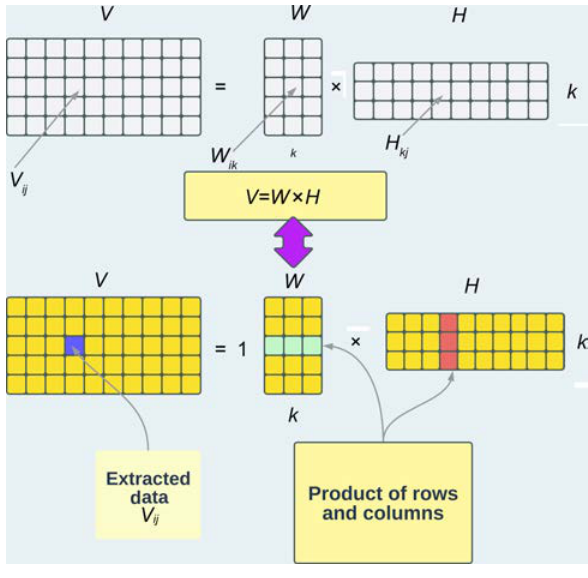
Fig. 1 Extracting data.